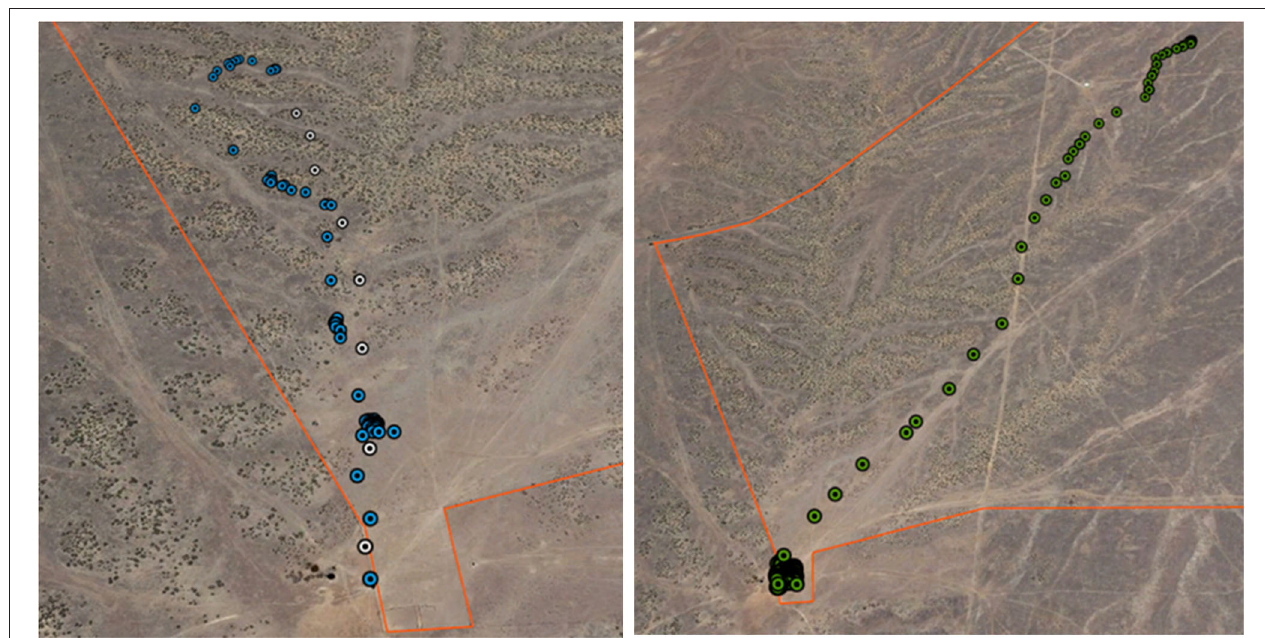
FIGURE 3 | Tracking data of a cow traveling to a water tank, drinking and leaving compared the movement pattern when access to water was denied (simulated water failure). The left map is an example of a normal watering event. White dots on the left graph show a cow walking to water and the blue dots show the cow leaving water. On the right map, the green dots show the cow coming to water and remaining at water during the water system failure simulation. Both maps include tracking that started 30min. before the cow arrived at the water tank and then an additional hour of